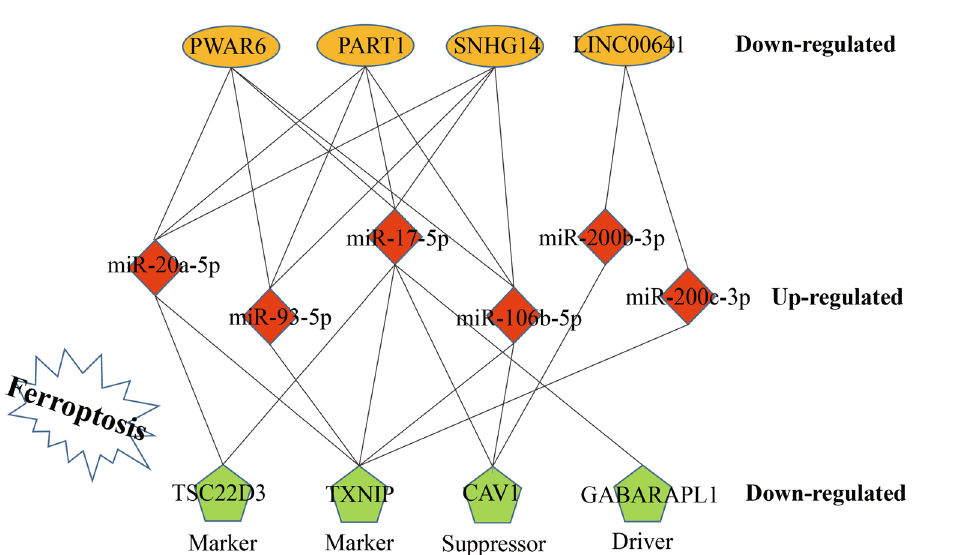
Figure 6. A ferroptosis-related ceRNA regulatory network in gastric